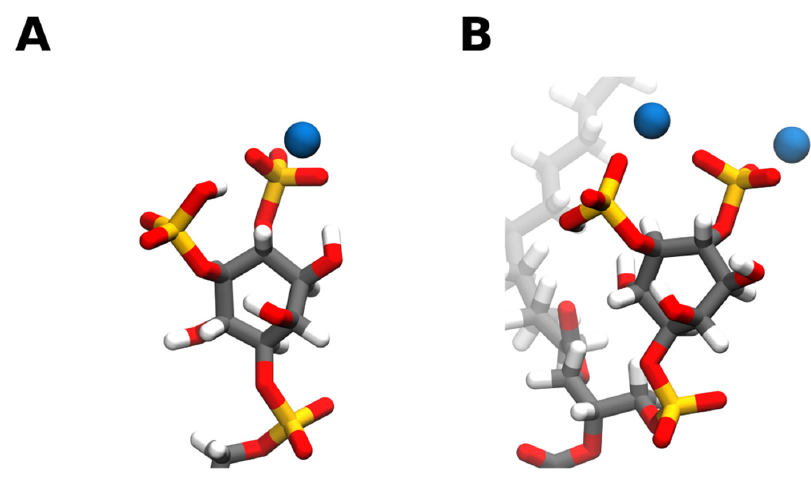
Figure 4. Snapshots of calcium ions interacting with the PI(4,5)P 2 headgroup phosphates. Calcium can bind to PI(4,5)P 2 either solely near the 4-phophomonoester ( A ) or in between the phosphomonoester groups ( B ). However, simultaneous binding between the two phosphomonoester groups is approximately 10 kcal / mol more unfavorable [31]. Carbon atoms are colored in grey, hydrogen in white, oxygen in red, phosphorus in orange, and calcium in blue. Snapshots obtained from a simulation of a bilayer consisting of 95:5 mol ratio POPC: PI(4,5)P 2 in the presence of calcium in a 5:1 calcium to PI(4,5)P 2 ratio, using the CHARMM36m forcefield run in GROMACS2019. Images were modeled using VMD.